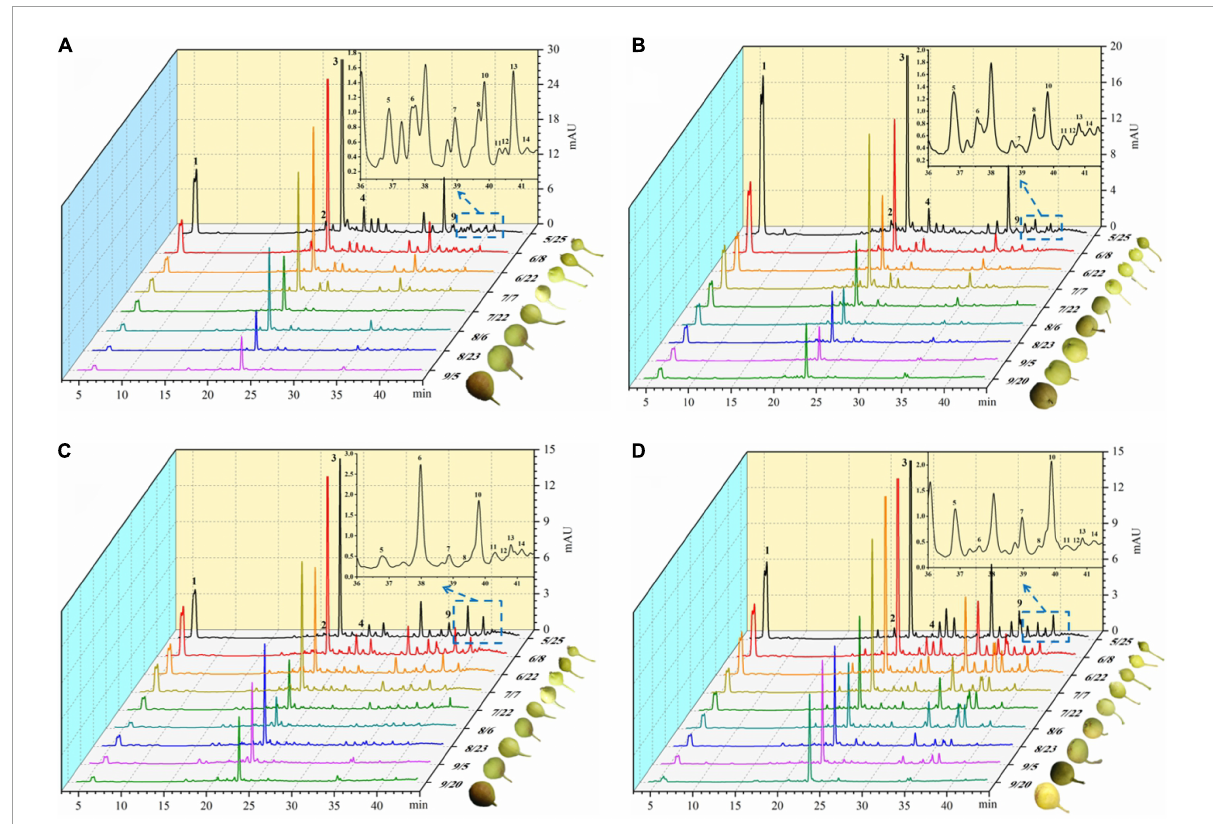
FIGURE3 Dynamics of four pear high performance liquid chromatography (HPLC). (A) Liquid chromatogram of Nanguo pear; (B) liquid chromatogram of Aksu Juju pear; (C) liquid chromatogram of Hongxiang pear; (D) liquid chromatogram of Luntai Juju pear. 1 Arbutin, 2 Catechin, 3 Chlorogenic acid, 4 Epicatechin, 5 Kaempferol hexoside-dideoxyhexoside, 6 Rutin, 7 Kaempferol-3-O-rutinoside, 8 Quercitrin, 9 Quercetin rhamnoside, 10 Isorhamnetin-3-O-rutinoside, 11 Kaempferol-3-O-glucoside, 12 Isorhamnetin-3-O-glucoside, 13 Kaempferol-3- acetylglucoside, 14 Isorhamnetin-3-acetylhexoside.